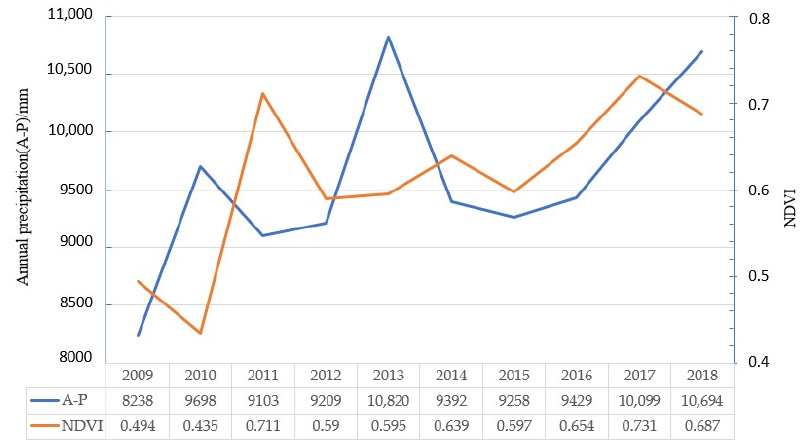
Figure 15. The annual variation of A-P and